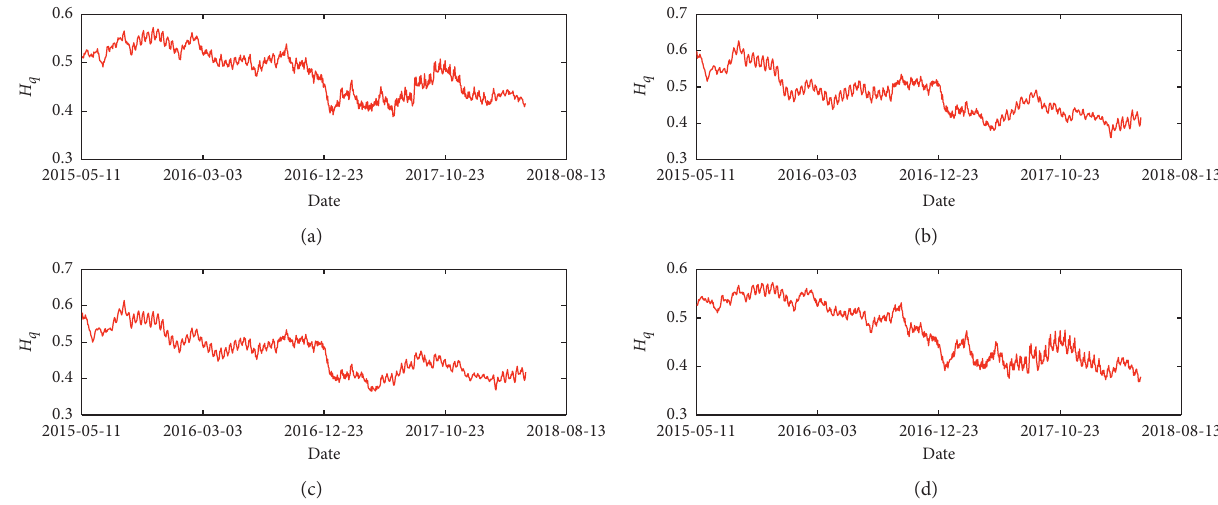
Figure 14: The time-varying scaling exponents for q � 2 for Chinese stock market returns and market participation willingness when window size is 250 days. (a) SME-YSI. (b) SSE50-YSI. (c) CSI300-YSI. (d) GEM-YSI.